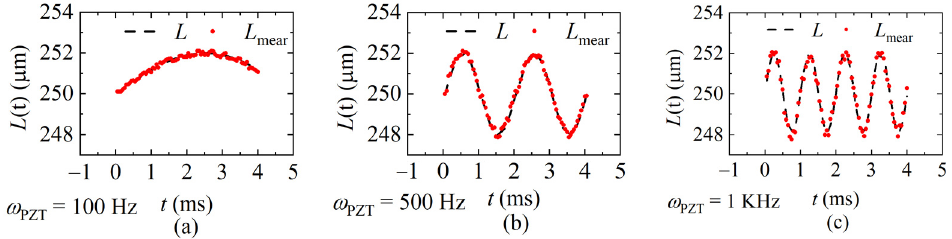
Figure 12. The demodulated distance at the sweeping rate of 20 KHz. ( a ) ω PZT = 100 Hz ( v max = 0.001 m/s); ( b ) ω PZT = 500 Hz ( v max = 0.006 m/s); ( c ) ω PZT = 1 KHz ( v max = 0.01 m/s).